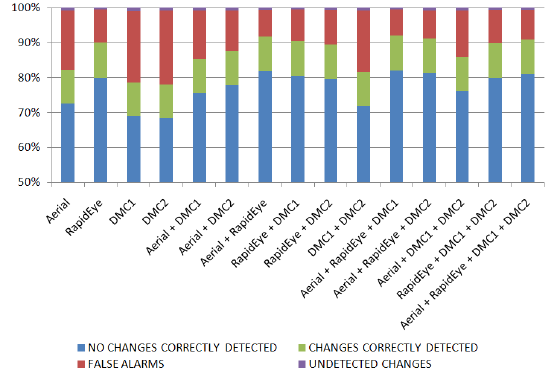
Figure 8. Performance of the change detection method in the whole dataset.